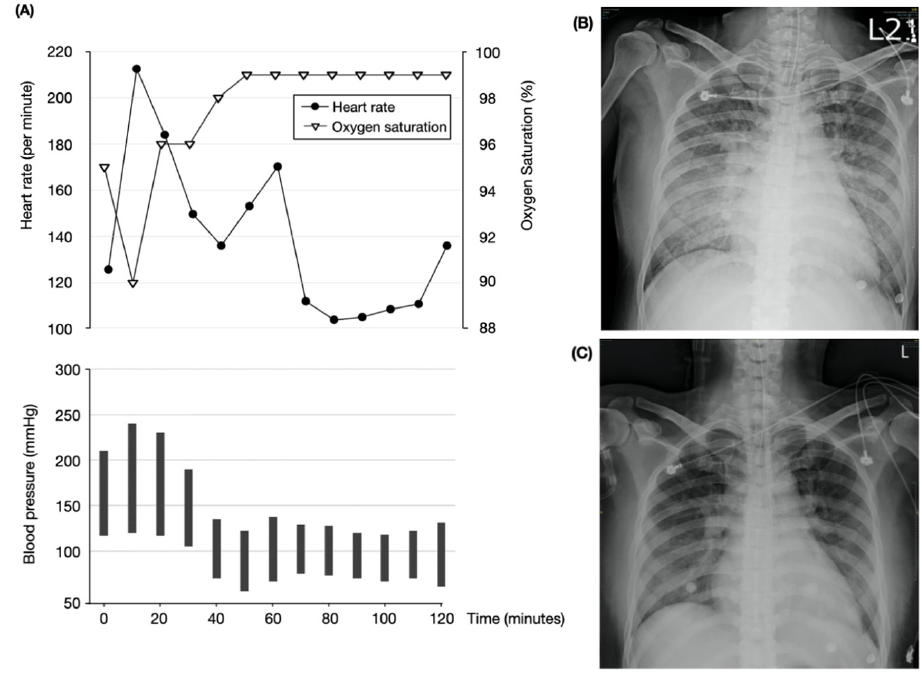
Figure 1. Intraoperative vital signs and postoperative chest radiography. ( A ) The patient had profound hypertension and tachycardia intraoperatively. ( B ) Chest radiography just after caesarean section showed bilateral pulmonary edema. ( C ) Pulmonary edema resolved after treatment on postoperative day 1. HR, heart rate; SpO 2 , oxygen